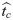
Predicted critical end time tc^ as the function of q for the four historical bubbles.(A) S&P 500 1987 bubble. (B) S&P 500 2007 bubble. (C) SSEC 2007 bubble. (D) SZSC 2009 bubble. Each panel shows the medians (red stars) and averages (black squares) of tc^ as functions of q = 0.01, 0.02, …, 0.99 for the fixed tend given in Table 1, over the population of window sizes spanning {dt = 750, 745, …, 125}. The blue line is the average of the L2 calibration based predictions over the same set of window sizes. For each panel, the black dashed line shows the respective position of tend, and the red dashed line shows the corresponding true critical date Tc.